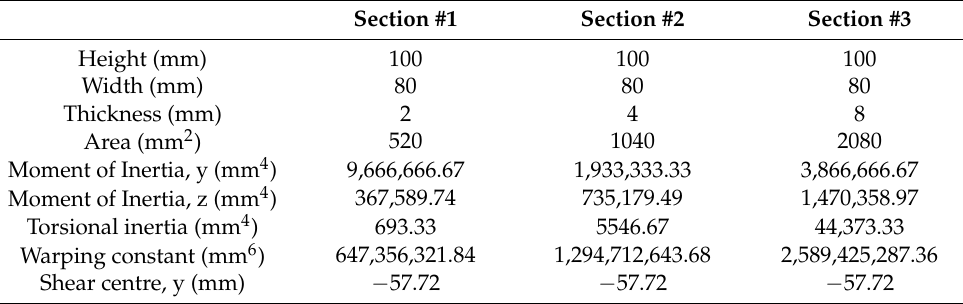
Table 1. Geometrical properties of the selected sections.